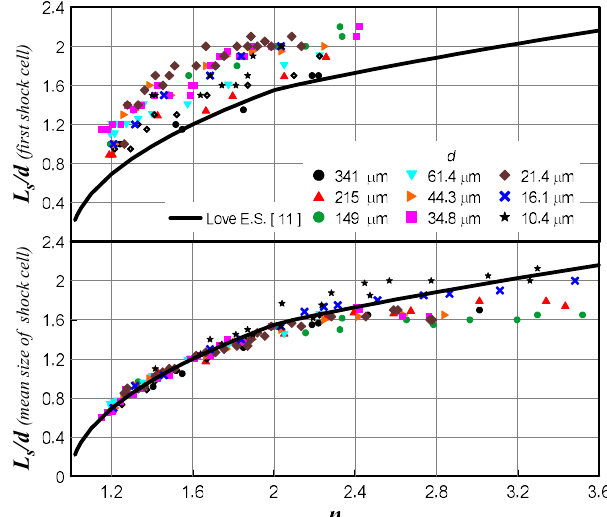
Figure 3. First barrel size and mean size of the barrels in real microjets.